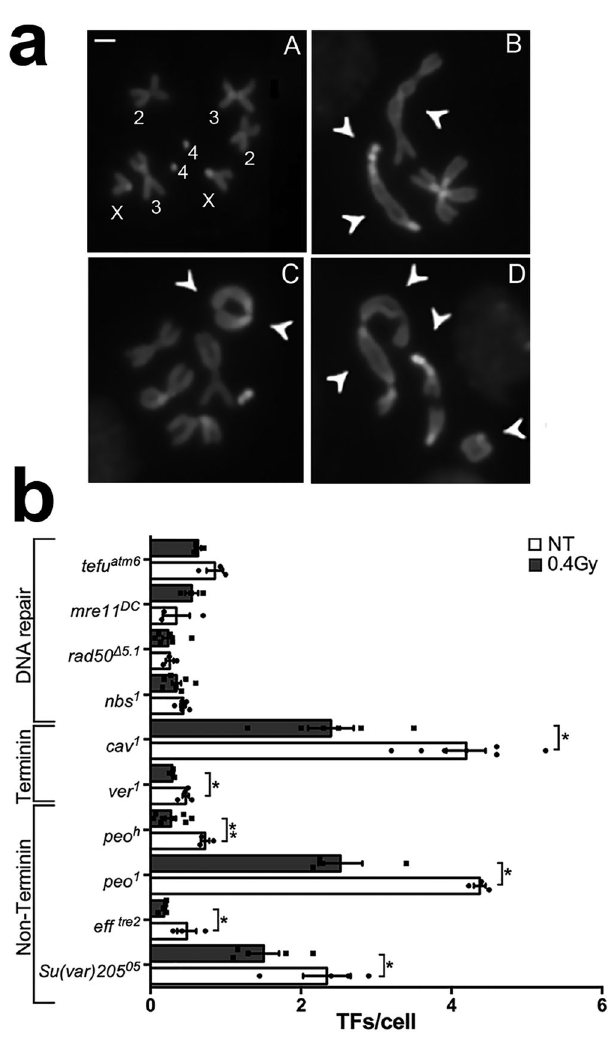
Fig. 4 Analysis of TFs frequency in telomere capping and DDR mutants exposed to 0.4 Gy LDR. a Examples of TFs scored for the TF frequency analysis. (A) Female wild-type metaphase; (B) female metaphase showing a Double Telomere Association (DTA) between the chromosomes 2 (arrows), a DTA involving both chromosomes 4 and both chromosomes X (arrows); (C) female metaphase showing a ring consisting of both X chromosomes (arrows) and a DTA between the chromosomes 4 (arrow); (D) female metaphase showing a multicentric chromosome con fi guration involving 3DTAs, a DTA between chromosome 4 and XR and a ring chromosome (arrows). b TF frequency (DTAs only) in 0.4 Gy LDR- pretreated and non-treated Drosophila strains mutated in genes encoding DNA damage repair factors ( tefu , mre11 , rad50 , and nbs ), proteins of terminin complex ( cav , and ver ), or proteins not associated to terminin complex ( peo , eff , and Su(var)205 ). (* p < 0.05; ** p < 0.01). DTAs double telomere associations; NT non-treated. Bar = 5 μ